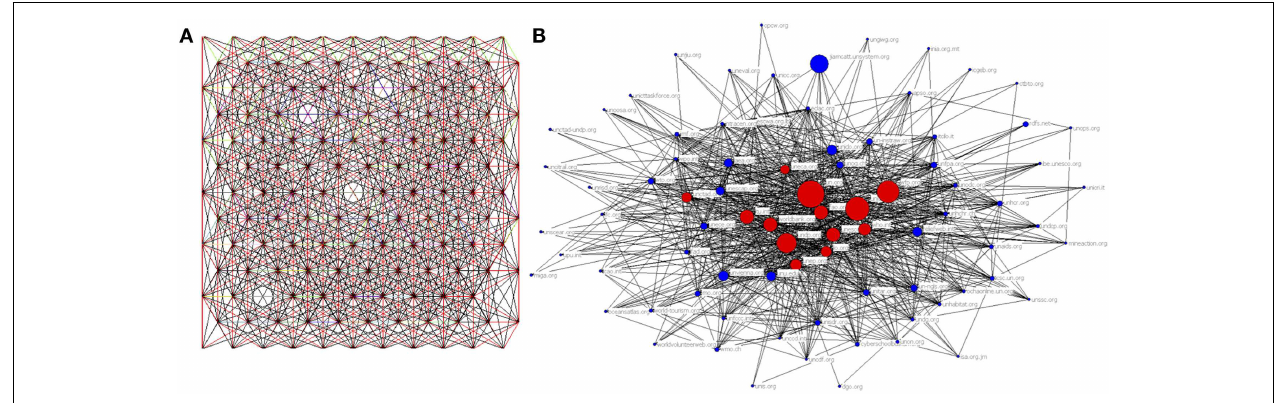
FIGURE 1 | (A) A mechanical system with non-local interactions among atoms modeled by non-local links and with some randomly located vacancies inducing links removal. (B) A network of relationships between 87 mutually linked United Nations websites [adapted from Cugelman